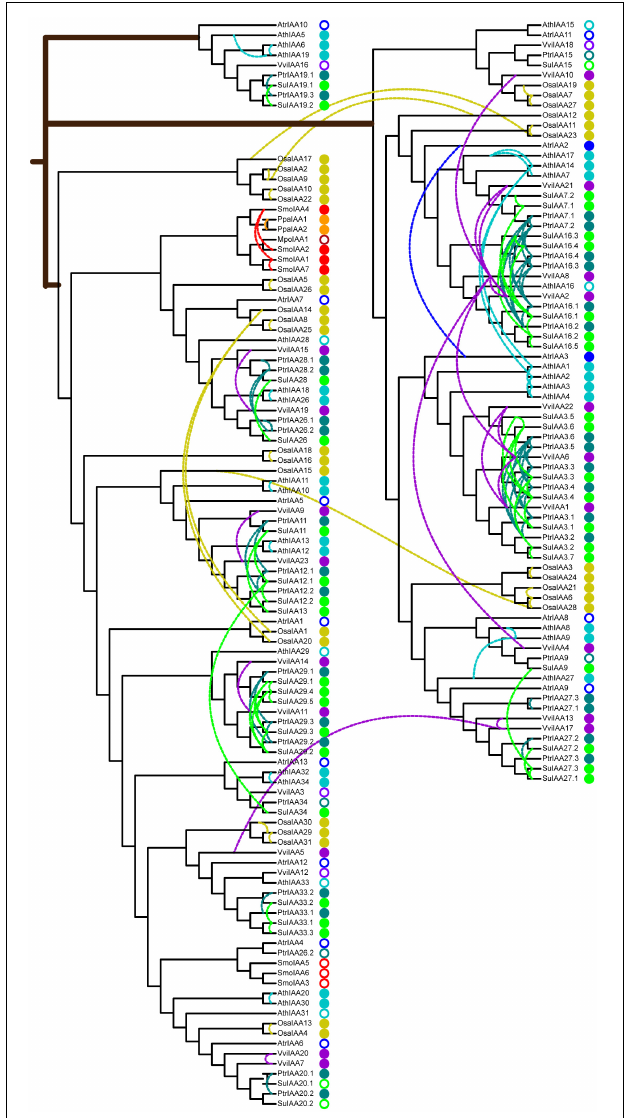
FIGURE 3 | Phylogenetic relationships of auxin/indole-3-acetic acid (Aux/IAA) proteins in nine typical land plants. The neighbor-joining tree was constructed with one MpoIAA, two PpaIAA, seven SmoIAA, 13 AtrIAA, 31 OsaIAA, 23 VviIAA, 36 PtrIAA, 38 SuIAA, and 29 AthIAA proteins. The colored solid circles indicate duplicated genes in different species, and the colored rings indicate non-duplicated genes in different species. The colored dashed links represent paralog duplicated pairs. Mpo, M. polymorpha ; Ppa, P. patens ; Smo, S. moellendorffii ; Atr, A. trichopoda ; Osa, O. sativa ; Vvi, V. vinifera ; Ptr, P. trichocarpa ; Su, S. suchowensis ; Ath, A. thaliana